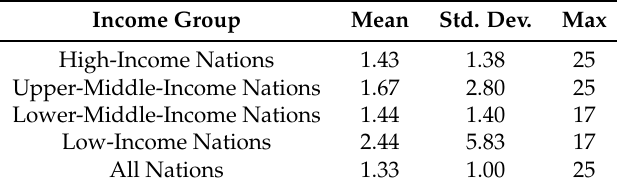
Table 5. Summary statistics on international collaborations by income group.